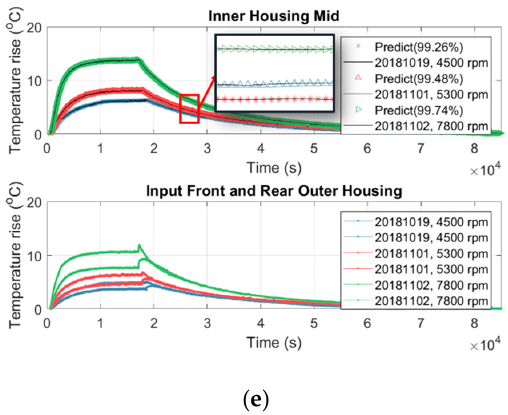
Figure 20. Using the 2I5O thermal-feature model (Table 6) to predict the internal temperature of the spindle at: ( a ) rear bearing A; ( b ) rear bearing B; ( c ) front bearing C; ( d ) front bearing D; ( e ) inner housing mid.